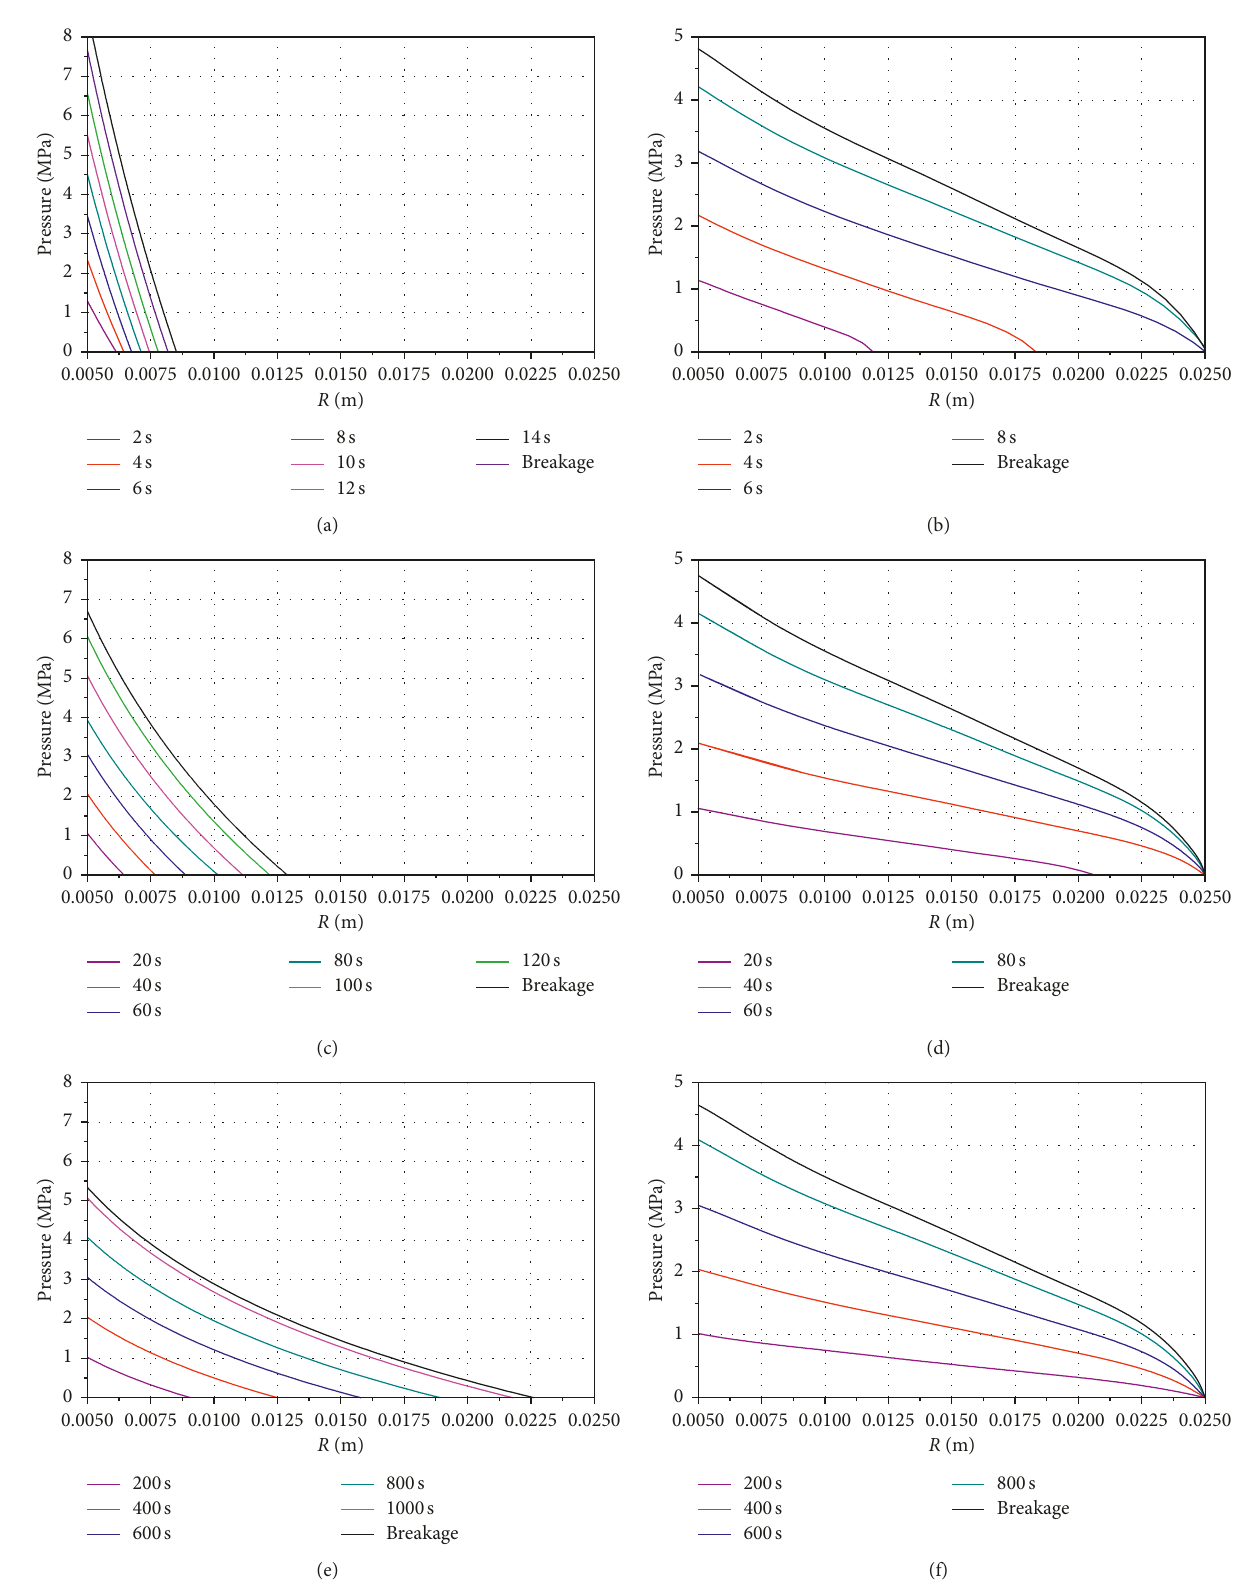
Figure 16: Plots of pore pressure distribution during fracturing (II). (a)